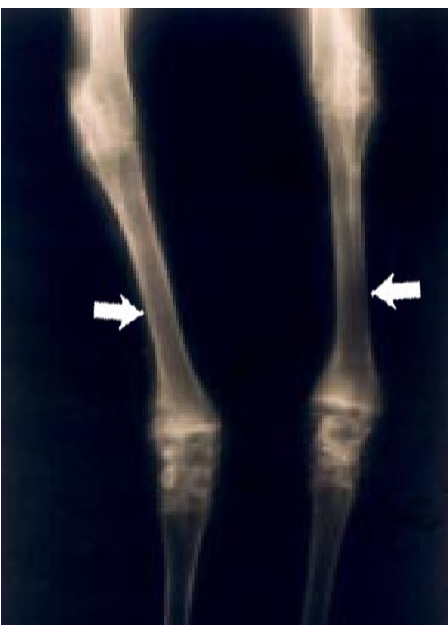
432 433 Figure 4. Radiographic view of the forelegs of a 1-year-old Qianbei-Pockmarked Figure 4. Radiographic view of the forelegs of a 1-year-old Qianbei-Pockmarked goat with phosphorus 434 goat with phosphorus deficiency. The medullary canals were wide and the cortex deficiency. The medullary canals were wide and the cortex was thin in the long bones of the forelegs 435 was thin in the long bones of the forelegs (White arrows). (White arrows).